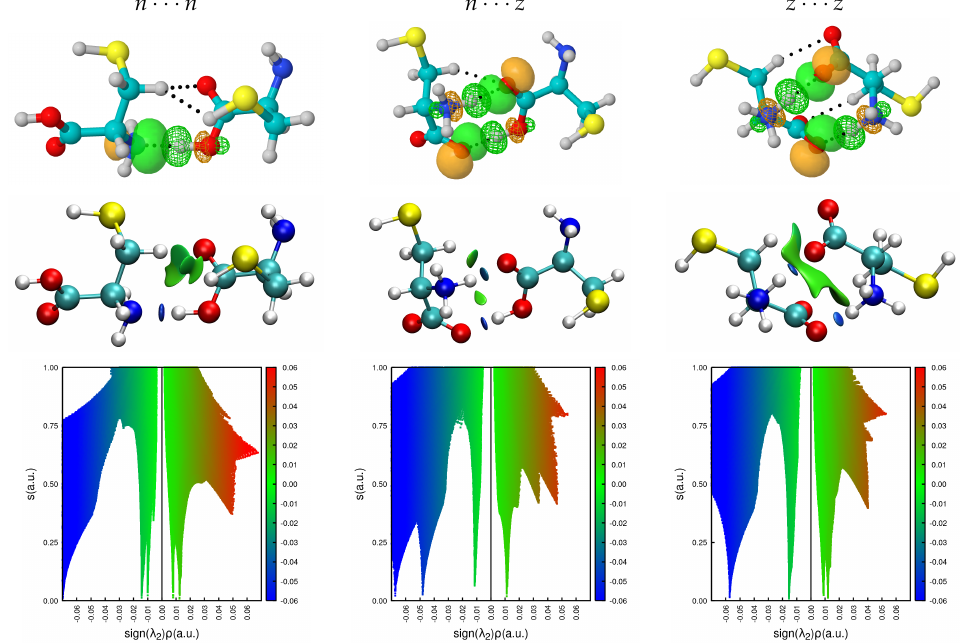
Figure 9. NCI surfaces and thoroughs describing the intermolecular contacts for the highest binding energy cysteine dimers. NBO pictures are also included to ease visualization of the